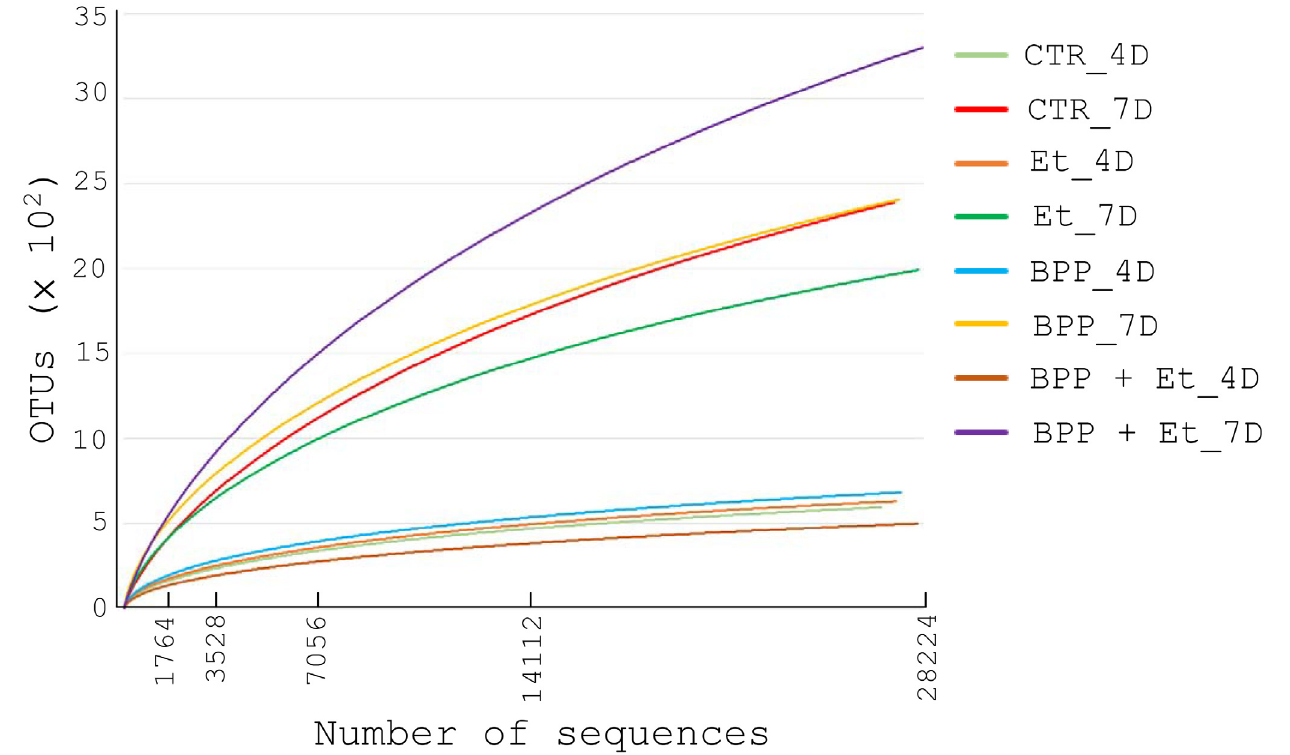
Fig 2. Rarefaction curves of bacterial OTUs in experimental samples from the guts of chickens fed with or without B . pilosa , infected with or without E . tenella . Rarefaction curves of bacterial 16S rRNA sequences from the guts of 18-day-old (4D) and 21-day-old (7D) chickens fed with or without B . pilosa , infected with or without E . tenella , as in Fig 1B, were analyzed.